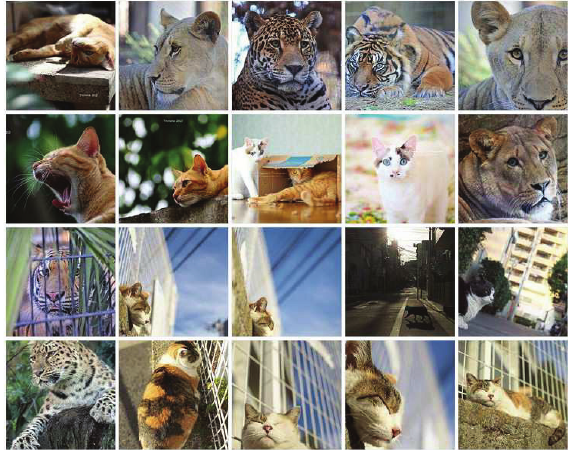
Fig. 2. Examples of images for ‘cat’ before step 3) in the proposed